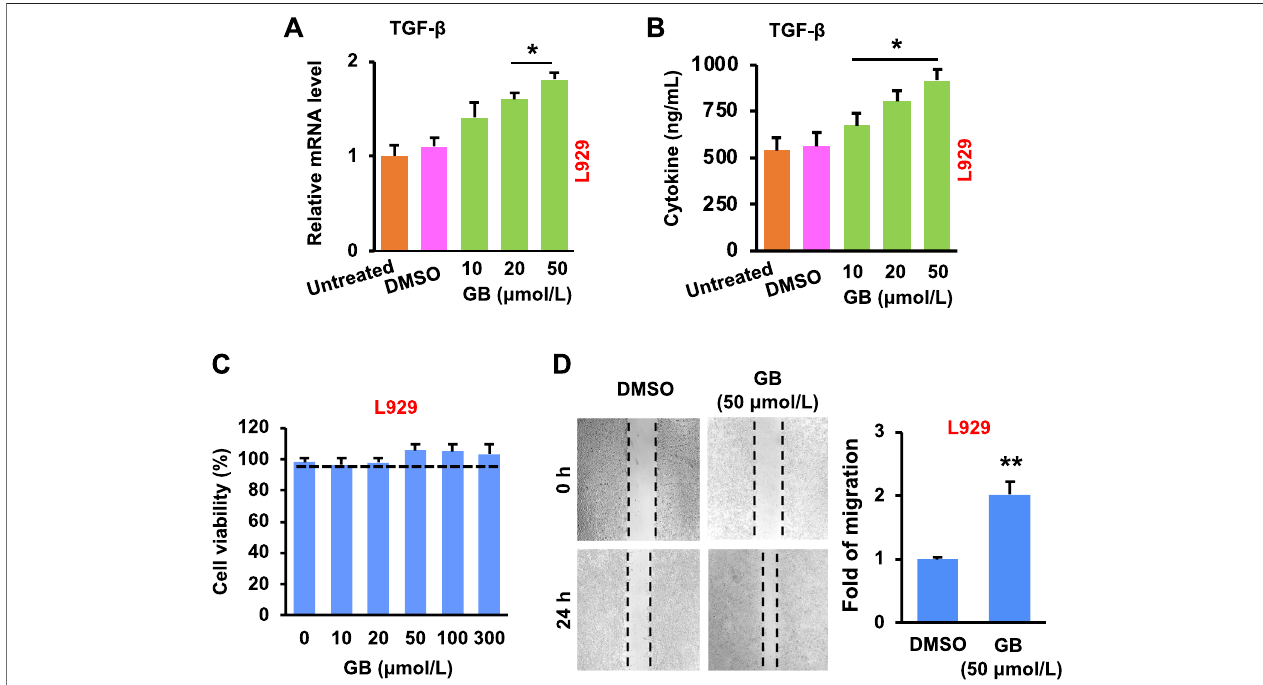
FIGURE2| GBpromotes invitro proliferativeactivityof fi broblasts. (A) ThelevelofTGF- β mRNAinL929followingGBtreatment(10,20,and50 μ mol/L)( n =3;* p < 0.05). (B) Therelease ofTGF- β protein inthe culture supernatant ofL929 following GBtreatment(10, 20,and 50 μ mol/L) ( n =3;* p < 0.05). (C) Cytotoxicity ofL929after the treatment ofGB (10, 20, 50, 100, and 300 μ mol/L; 0 =DMSO alone). (D) The empty places before and after treatment of GB(50 μ mol/L) were measured for the fold of migration (the magni fi cation = ×10) ( n = 3; ** p <